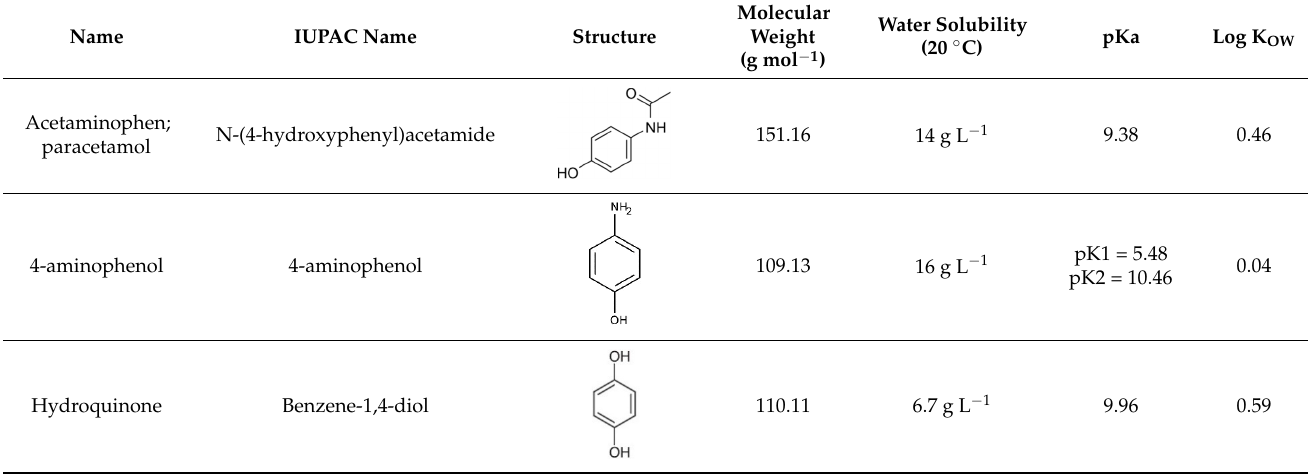
Table 1. Formulas, molecular structures and some properties of the compounds discussed in this work [27].